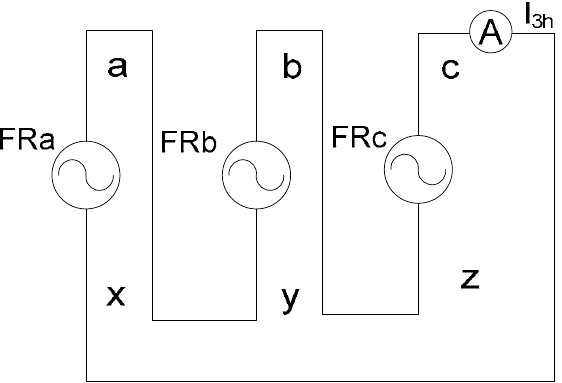
Figure 9. Wiring diagram without zero sequence path.